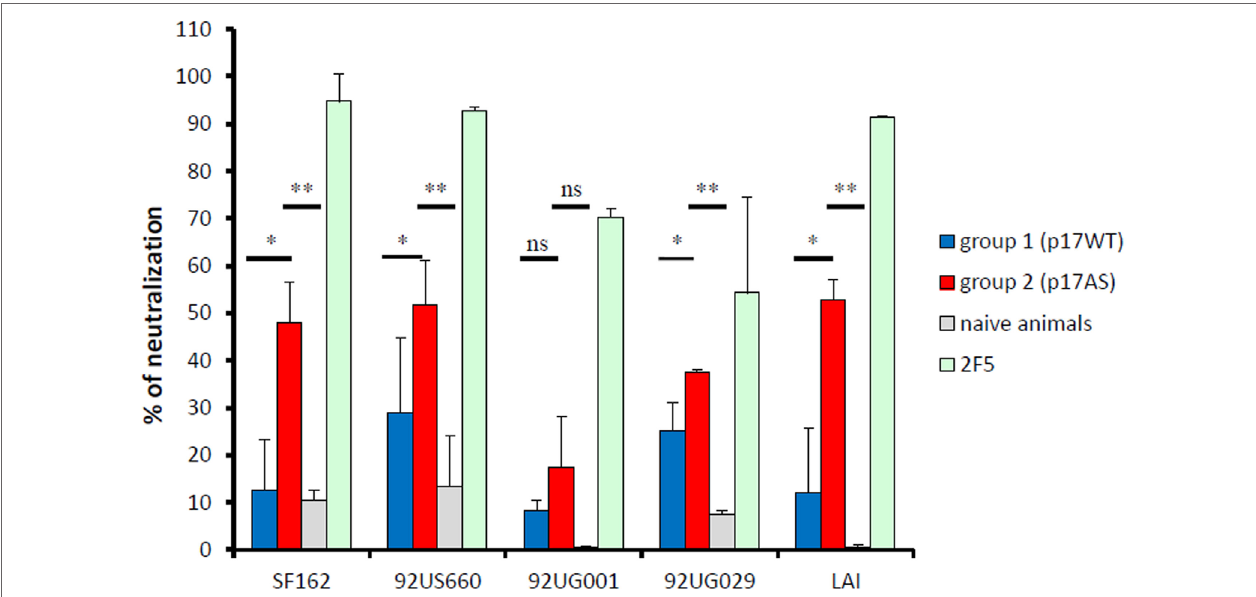
FigUre 5 | Neutralizing activity of p17-induced anti-gp41 antibody responses. Neutralizing efficacy of purified IgG at d98 from animals immunized with p17WT (blue bars) and p17AS (red bars) against viral particles pseudotypes using envelop proteins of various isolates. Reference antibody 2F5 (green bars) and sera from non-immunized animals (gray bars) were used as positive and negative controls, respectively. Each value represents the mean of the neutralizing efficacy of purified IgG from the three rabbits of each group, measured individually in duplicate. Error bars represent the SD of the same measures. Stars indicate significant differences between the two groups in neutralizing activity against the